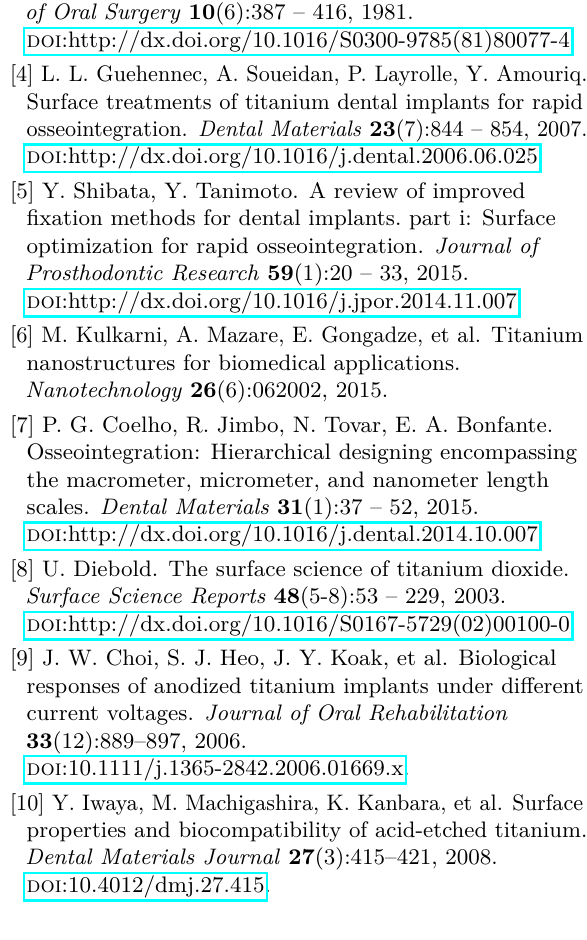
Figure 5. Dissolution profiles of Ti grade 2 and Ti grade 5 discs in 85% H 2H O and 30% H O and 30% HCl at temperatures of 20°C, 40°C and 2 2 2